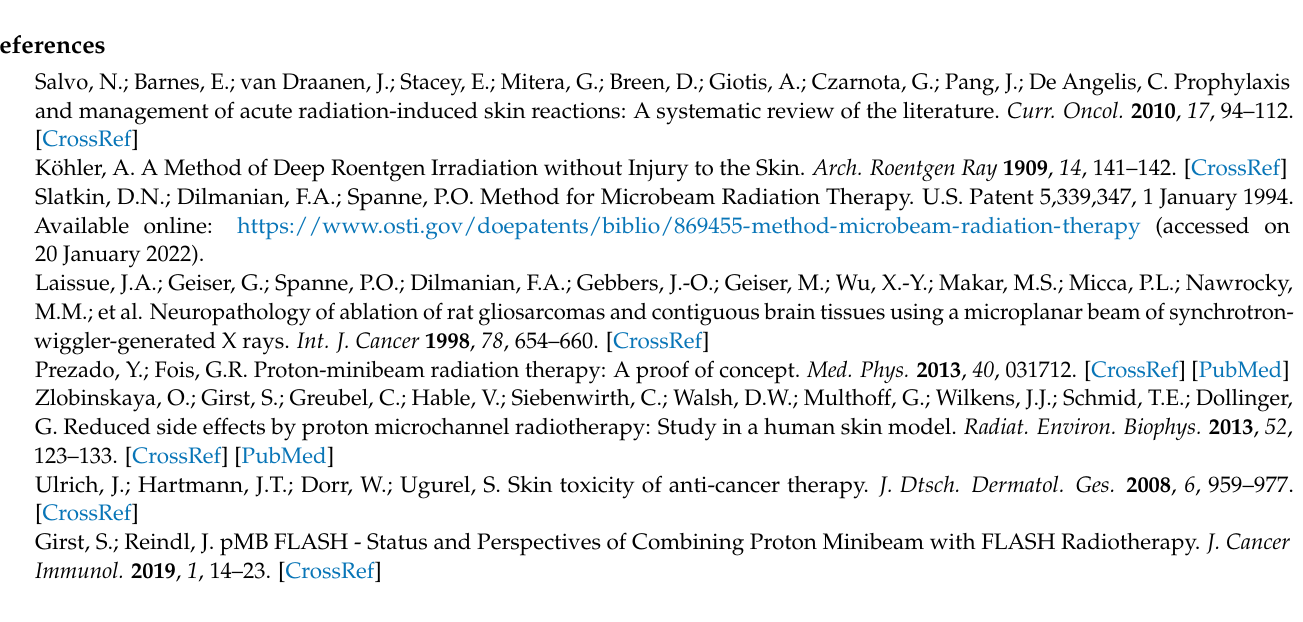
foci per cell with increasing repair time; Figure S2: Grey scale images of Figure 3B showing the red (53BP1) and green ( γ -H2AX) channel; Figure S3: Grey scale images of the Figure 4 showing red (53BP1) and green ( γ -H2AX) channels; Figure S4: Time course of the dynamics of cellular DSB foci and pan- γ -H2AX cells after sham minibeam irradiation. Table S1: Average percentages (+ − SD) of cells with foci (% cwf) for the different irradiation geometries; Table S2: Average percentages (+ − SD) of cells showing pan- γ -H2AX positive nuclei (% pan- γ -H2AX) for the different irradiation geometries; Table S3: Average percentages (+ − SD) of cells expressing active caspase 3 (% act.cas3) for the different irradiation